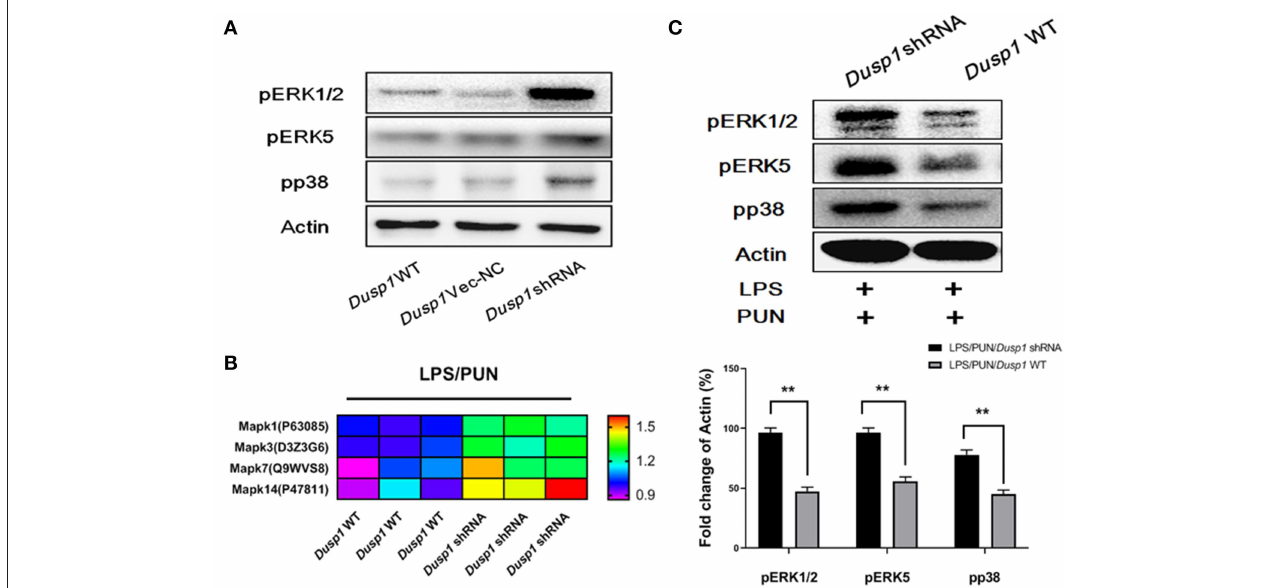
FIGURE 3 | ERKs and p38 are negatively regulated by MKP1 in macrophages. (A) Effects of Dusp1 interference on downstream MAPKs members. The lentivirus carrying M_ Dusp1 -shRNA and Dusp1 -Vector-NC was designed and inserted into RAW264.7 cells. The phosphorylation levels of ERK1/2, ERK5, and p38 were measured 12h later by Western blot. (B) Investigation on the phosphorylation level of downstream MAPKs members. Dusp1 WT and knockdown cells were pretreated with 20 µ M PUN for 3h and then treated with 1 µ g/ml LPS for 12h, as indicated. The phosphorylation level of each MAPKs members was detected via phospho-proteomics approach. Three independent experiments were performed. The proteins with fold changes (in log2 value, of control group) higher than 1.2 are listed in the heatmap. (C) Identification of the phosphorylation of MAPKs members. Dusp1 WT and knockdown cells were pretreated with 20 µ M PUN for 3h and then treated with 1 µ g/mL of LPS for 12h, as indicated. The phosphorylation level of each MAPK member was detected via Western blot. Data are expressed as mean ± SD of three independent experiments. ** p < 0.01 indicates statistically significant differences between indicated